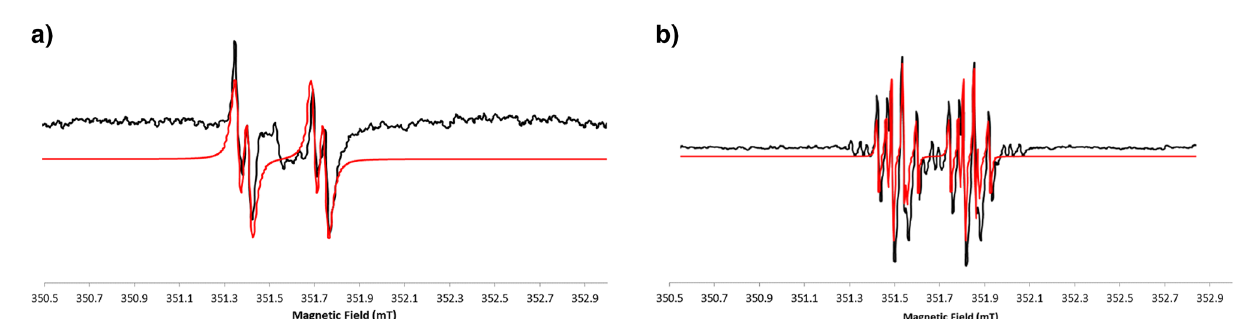
Figure 10. CW X-band EPR spectra at 298 K of HGA (black lines, acquired at 9.87 GHz microwave frequency, 0.1 mT modulation amplitude, 5 mW microwave power) with best-fit simulations (red lines): ( a ) in the presence of NaOH when the solution is black; ( b ) in the presence of NaOH when the solution is